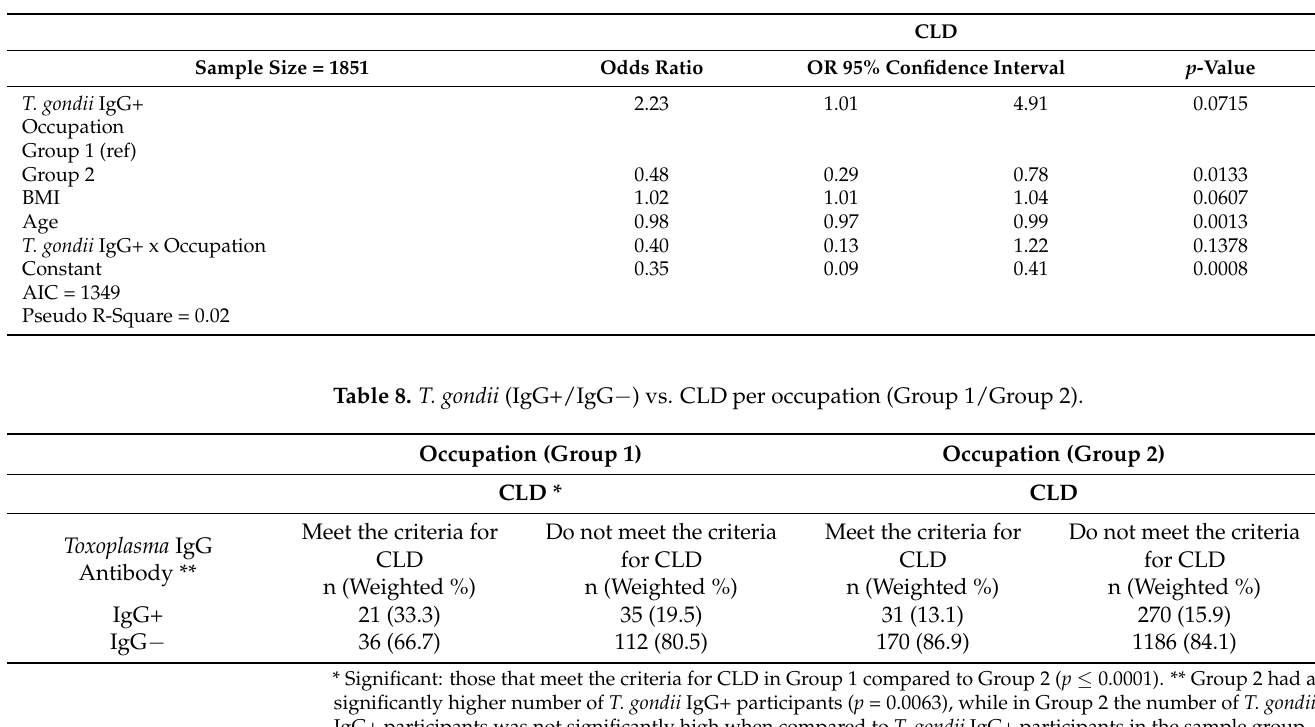
Table 7. Results of binomial logistic regression for CLD on T. gondii (IgG+/IgG − )—adjusted for BMI, age, and occupation (Group 1/Group 2).